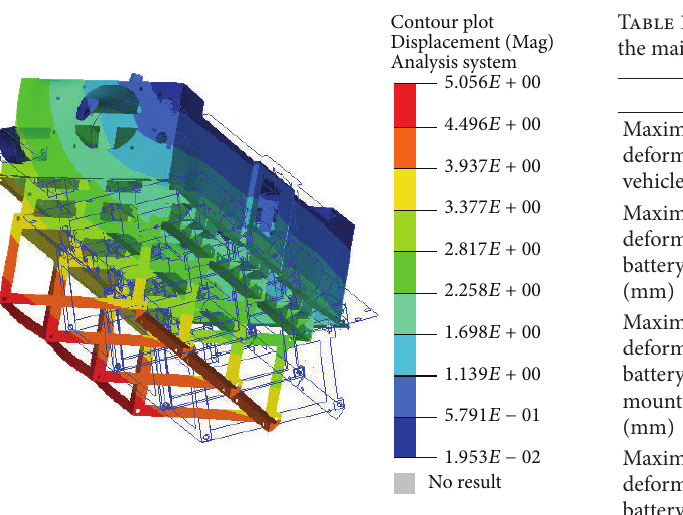
Figure 8: The deformation comparison of simulation picture of E- REV battery pack 1 inner structure under rear-end collision test after lightweighting the main parts.